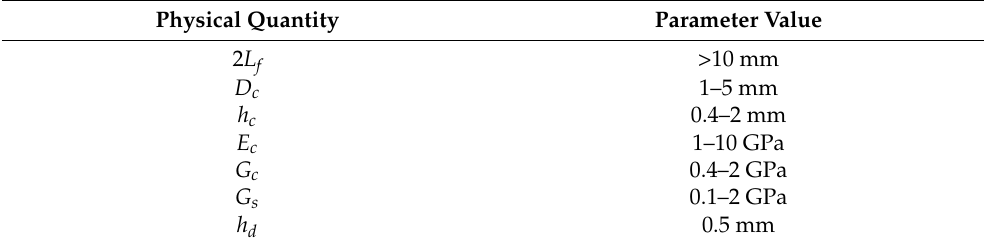
Table 1. Parameter-value range of each physical quantity.